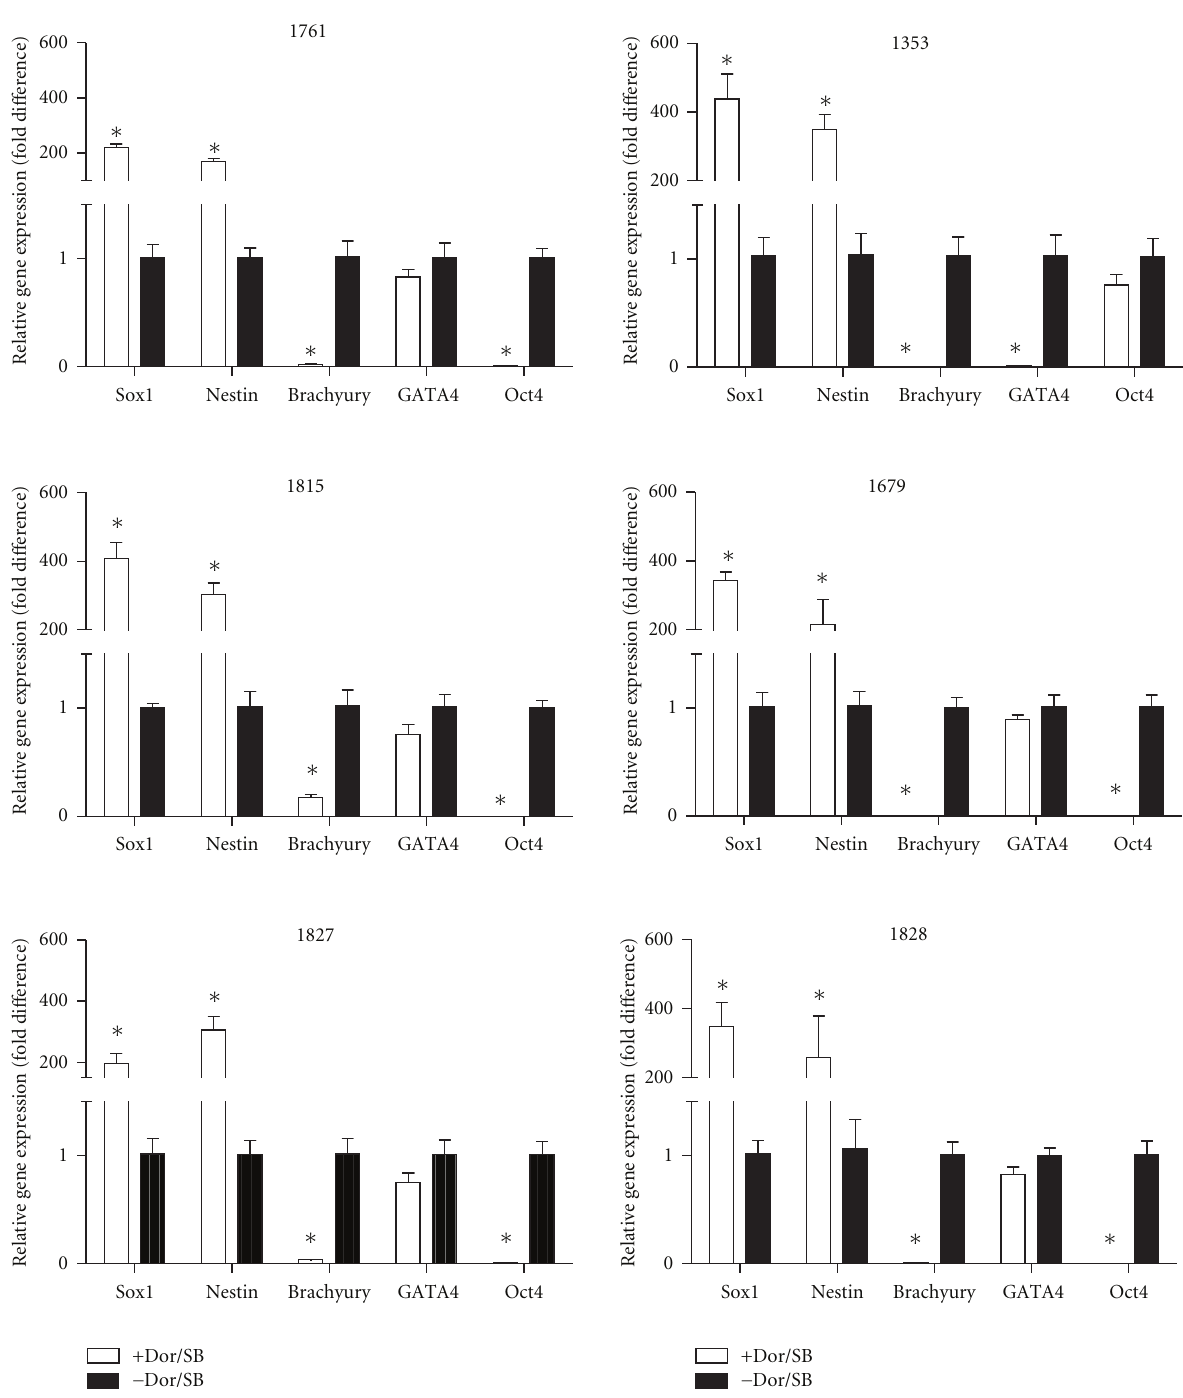
Figure 4: Quantitative gene expression analysis of PD and control lines with and without Dor/SB. Expression levels of neuroectoderm (Sox1 and Nestin), mesoderm (Brachyury), endoderm (GATA4), and pluripotent markers (Oct4) were assessed by quantitative PCR. The y -axis represents means + SEM of relative expression levels of each gene in the EBs with Dor/SB relative to no Dor/SB treatment ( ∗ P < 0 . 01). Left panel depicts lines from healthy donors; right panels depicts cell lines derived from patients with PD. Data are presented as mean + SEM compared to the controls ( n = 3, except 1679, n = 2). P - value of each study was assessed by one-way ANOVA along with Newman-Keuls post- hoc